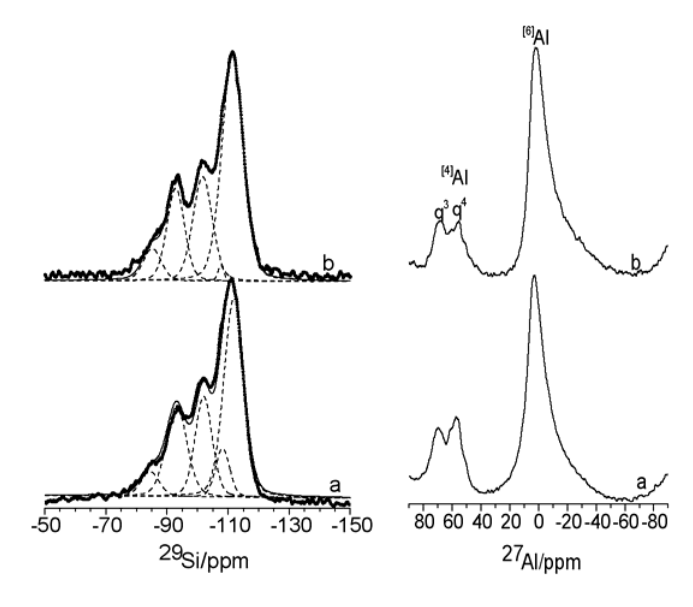
Figure 3. 29 Si- (left) and 27 Al- (right) MAS-NMR spectra of acid treated montmorillonites (a): K10; (b):